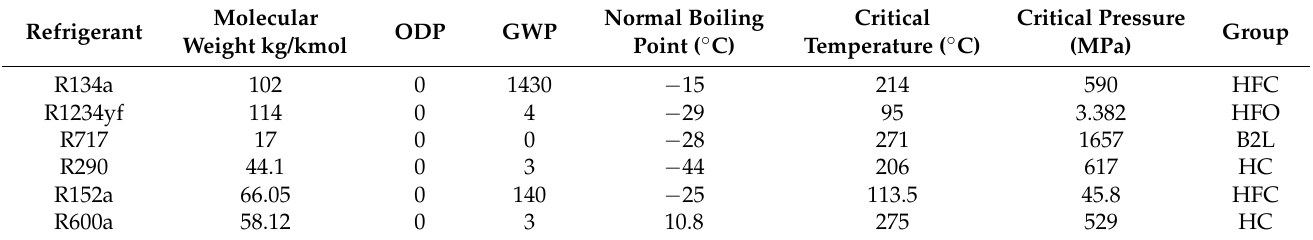
Table 1. Comparison of parameters of